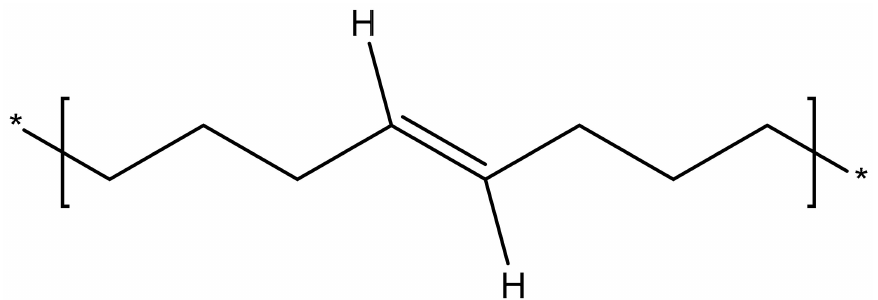
Figure 1. Chemical structure of trans-polyoctenamer